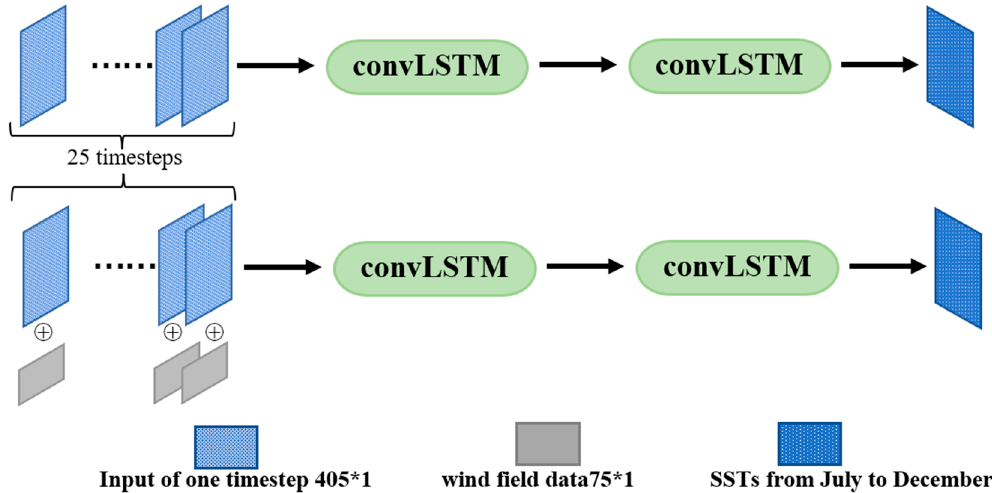
Figure 2. convLSTM structure, including two ConvLSTM2d layers.